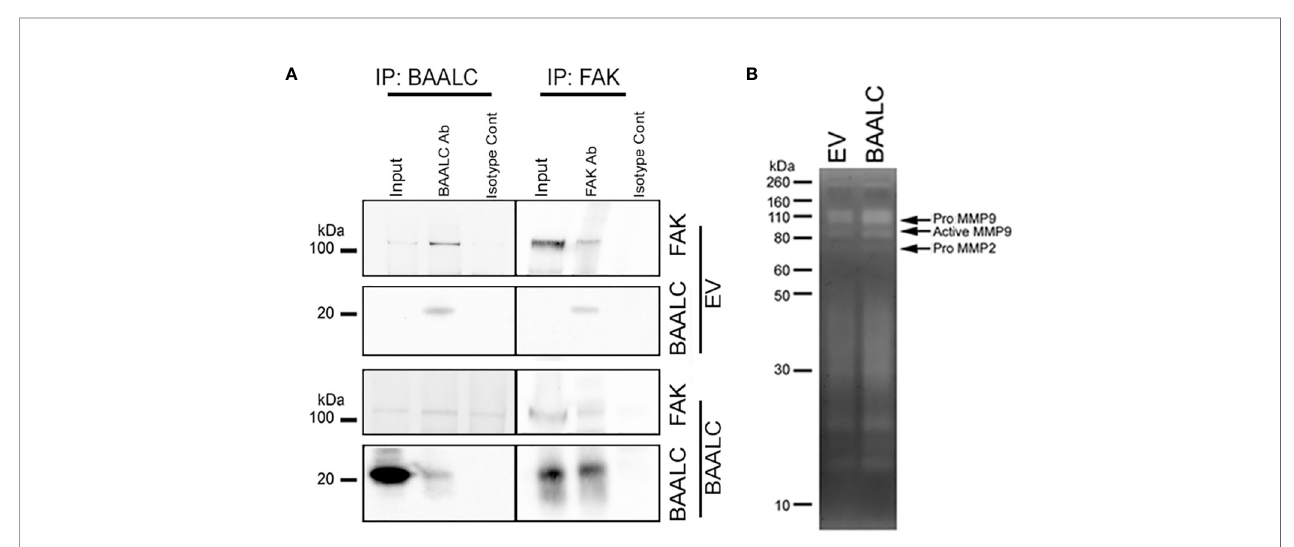
FIGURE 7 | BAALC can interact with FAK and leads to increased active MMP-9 in vitro . MCF-7 cells stably expressing an empty vector (EV) or BAALC were generated. (A) MCF-7 cells were lyzed, and BAALC was immunoprecipitated from cell lysates with an anti-BAALC antibody, or an IgG isotype control. Co- immunoprecipitated FAK was identi fi ed by western blot. Alternatively, endogenous FAK was immunoprecipitated with an anti-FAK antibody, and co- immunoprecipitated BAALC identi fi ed by western blot. Blots are representative of three independent experiments. (B) Conditioned media from MCF-7-EV and BAALC cells was electrophoresed on 10% gelatin zymography gels, and gels were stained before being visualized for MMP activity. Gels are representative of three independent